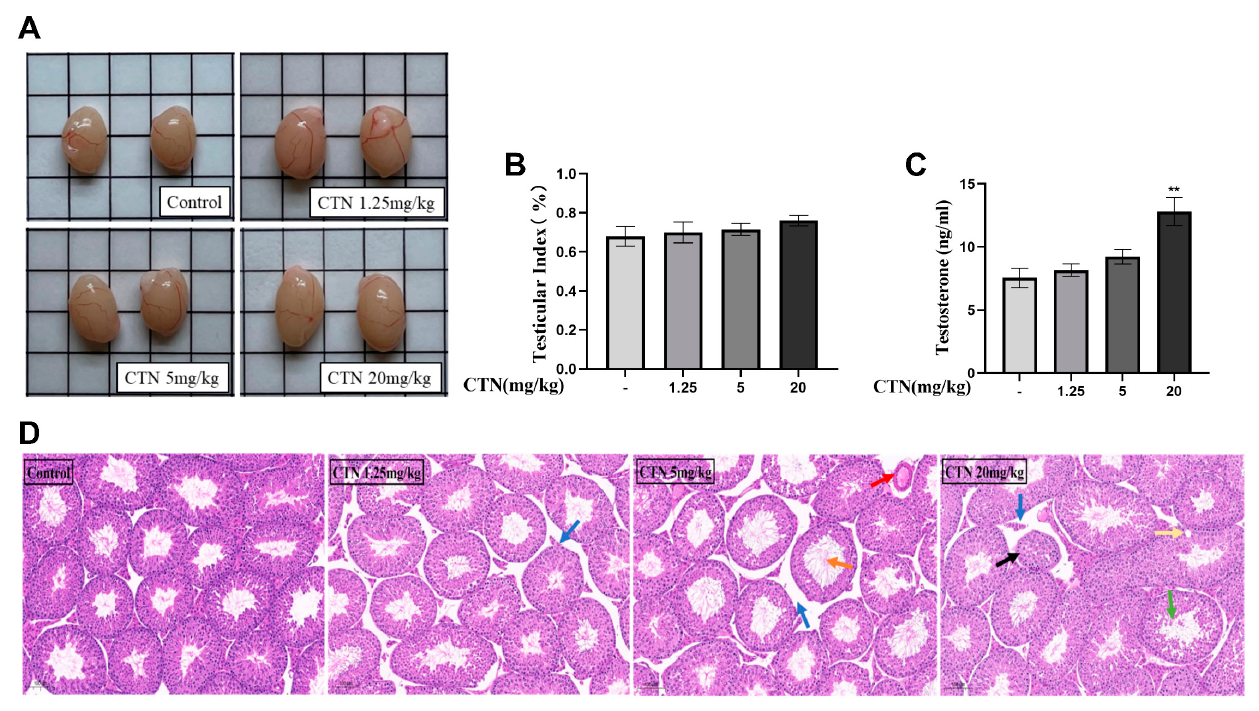
Figure 1. Effects of CTN on testicular damage in mice. ( A ) The appearance of mice testes; ( B ) The testicular index; ( C ) Serum testosterone concentration; ( D ) Histopathological analysis in testis tissue. (Blue: enlarged intercellular matrix; orange: increased luminal diameter; red: vascular congestion and dilatation; black: luminal obstruction; yellow: vacuolation of germinal tubules; green: luminal cell detachment; scale bar: 100 µm). The above data are expressed as SEM ± mean, compared with the control group, ** p < 0.01.